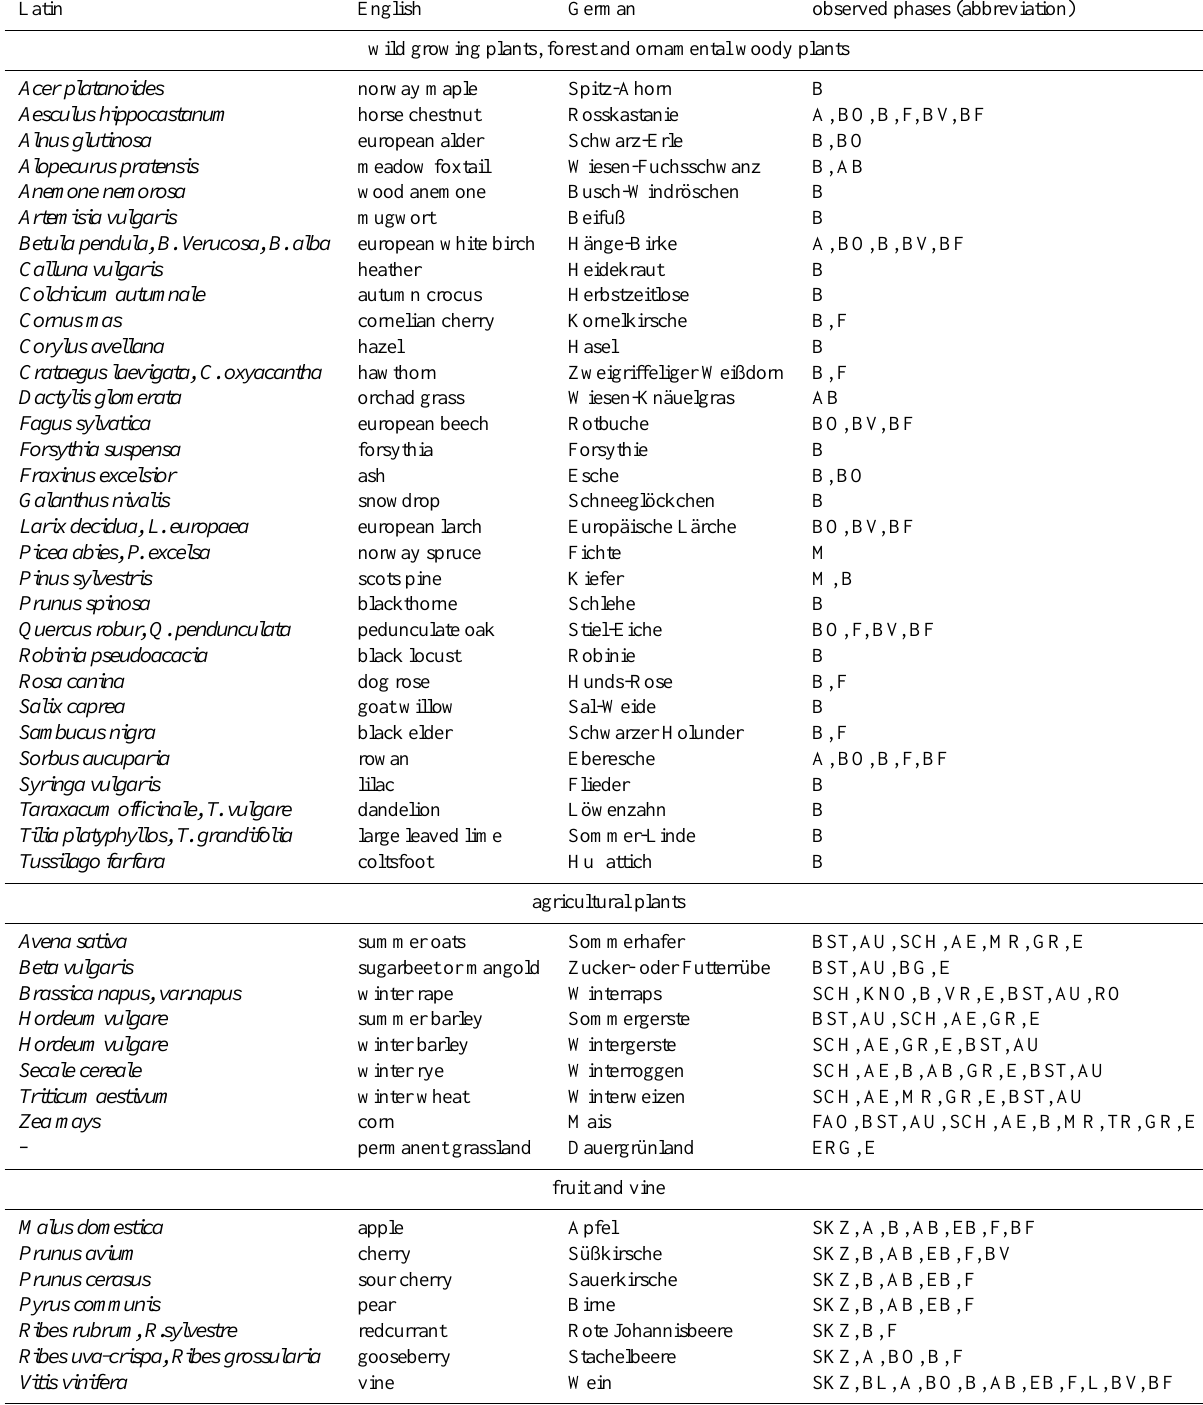
Table 1. Plants and their phenological phases in the current observation programme of Deutscher Wetterdienst. Abbreviations are explained in Table 2. German names are provided for users accessing the data via DWD’s